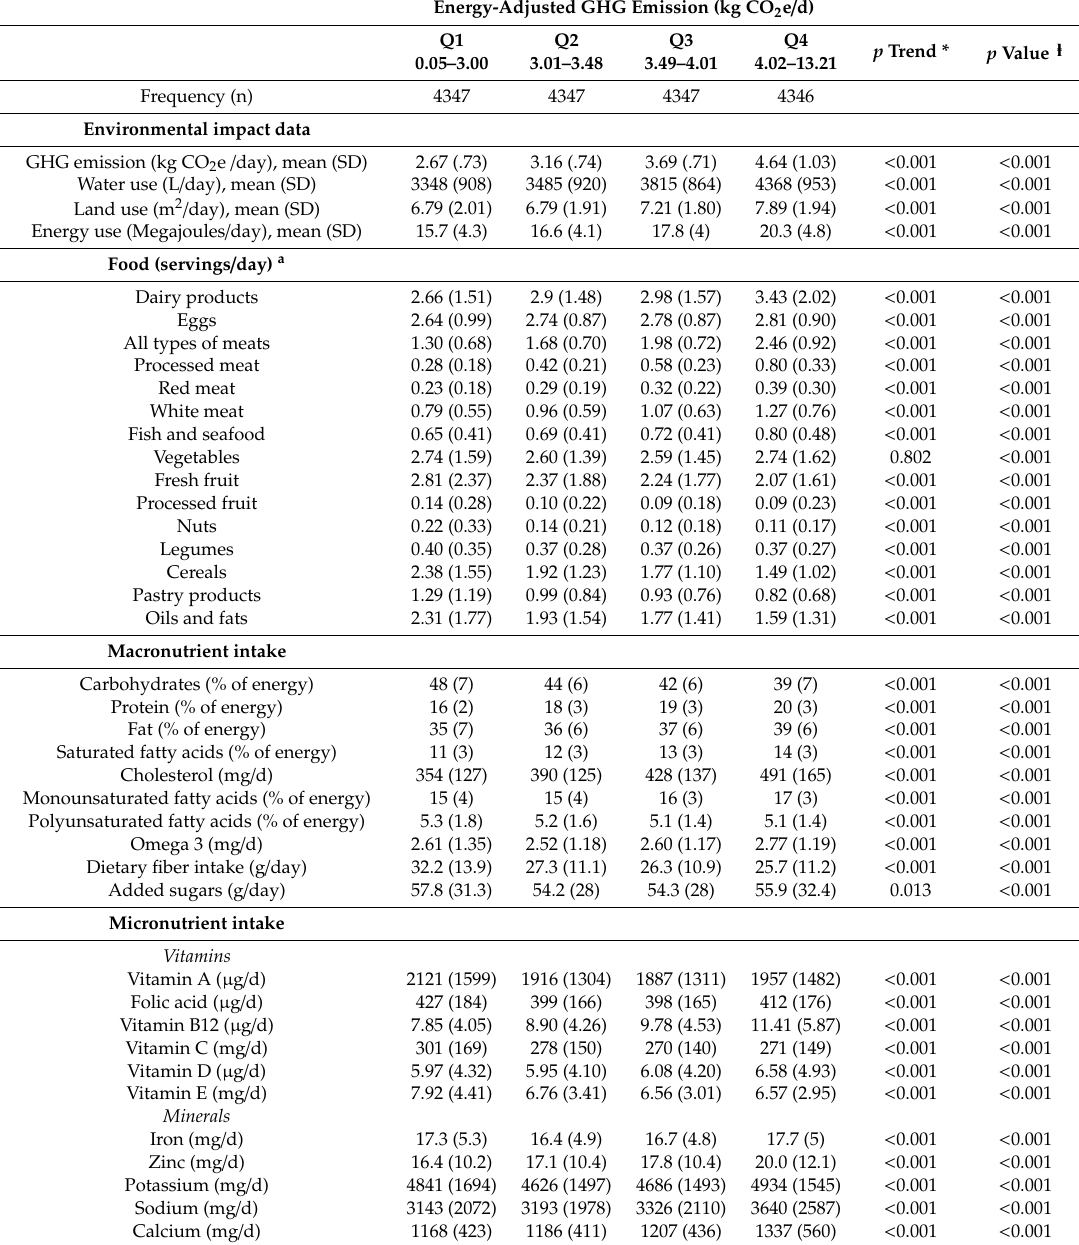
Table 2. Environmental impact, food group consumption and nutrient intake of the 17,387 participants of the SUN cohort assessed in the current study, 1999–2019, according to energy-adjusted quartiles of the dietary greenhouse gas (GHG) emissions.